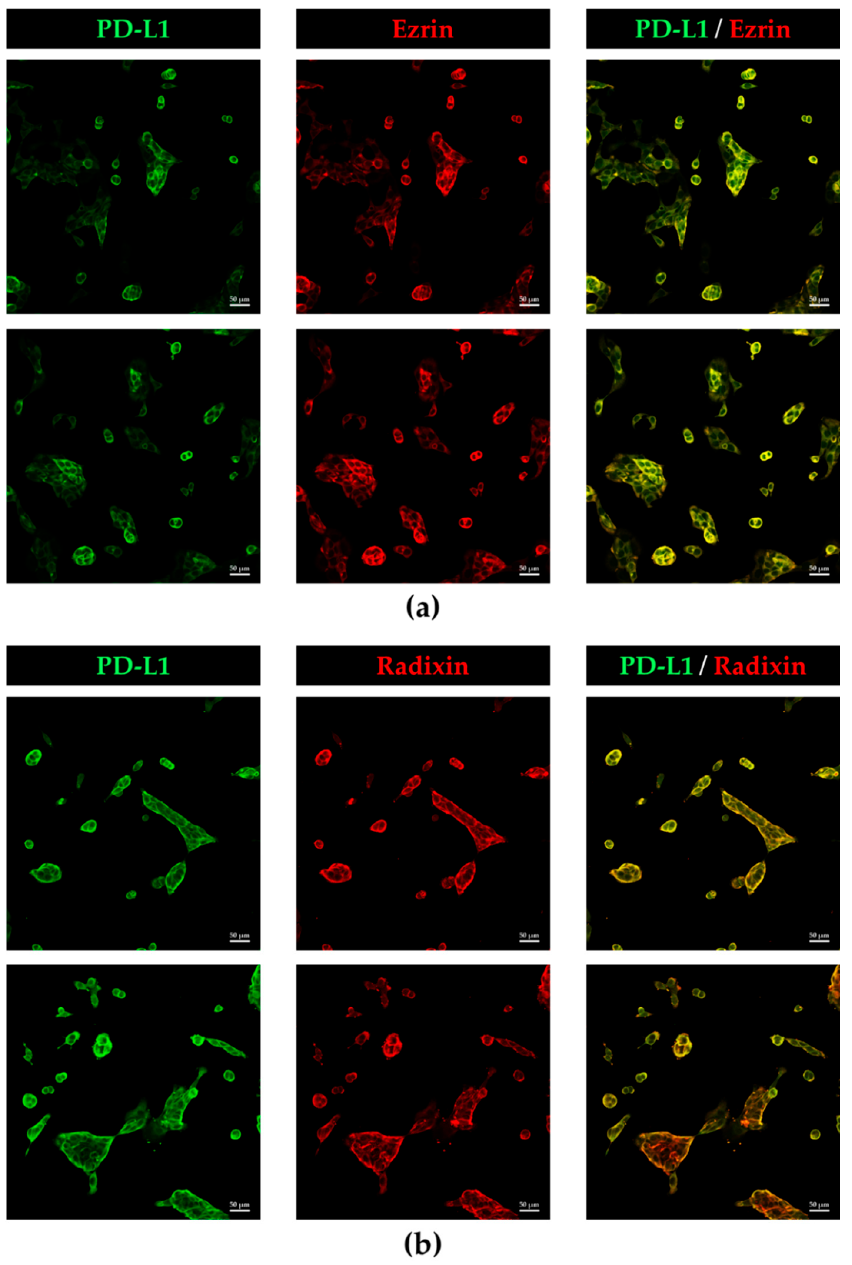
Figure 3. Colocalization of programmed death ligand-1 (PD-L1) with ezrin and radixin in the plasma membrane of KP-2cells. In a three-dimensional reconstruction of optically sectioned KP-2 cells obtained by confocal laser scanning microscopy analysis, PD-L1 (green) labelled with Alexa Fluor 488 was highly colocalized with ( a ) ezrin and ( b ) radixin (red) labelled with Alexa Fluor 594, especially on the plasma membrane. Scale bars: 50 µm. All images are representative of at least three independent experiments.